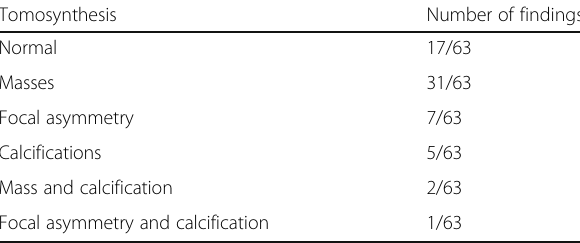
Table 4 Tomosynthesis findings among the studied population Tomosynthesis Number of findings